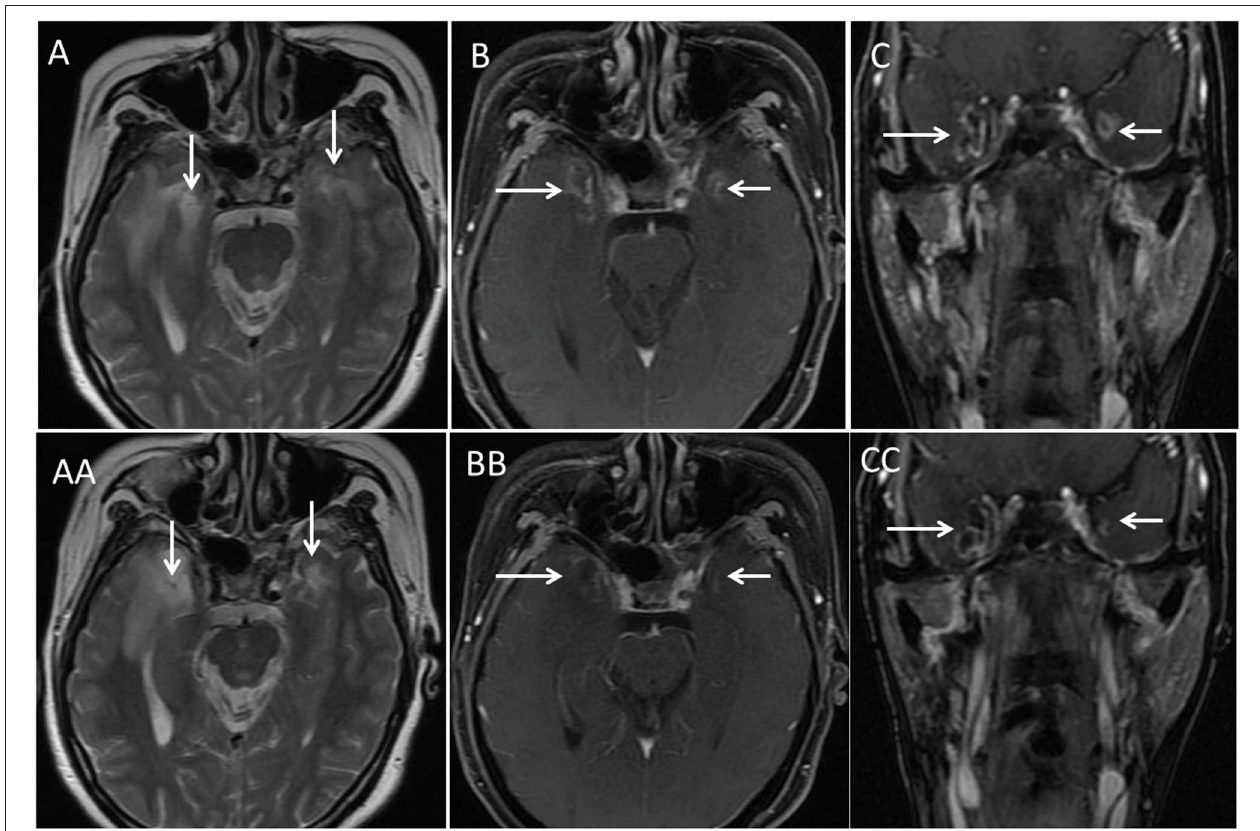
FIGURE 1 | Illustration of bilateral TLN (arrows) on MRI. This was a 47-year-old woman with T4N1 nasopharyngeal cancer. She received induction chemotherapy followed by concurrent chemo-IMRT. Routine follow-up at 61 months after IMRT demonstrated bilateral TLN (arrows) on axial T2-weighted MRI (A) and postcontrast axial (B) and coronal (C) T1-weighted MRI. However, she had normal cognitive function (MMSE score 28). She underwent the wait-and-see policy, and no intervention was prescribed to her. With long-term follow-up (28 months), she did not show impaired cognitive function. The necrotic mass remained nearly unchanged on axial T2-weighted MRI (AA) and postcontrast axial (BB) and coronal (CC) T1-weighted MRI.